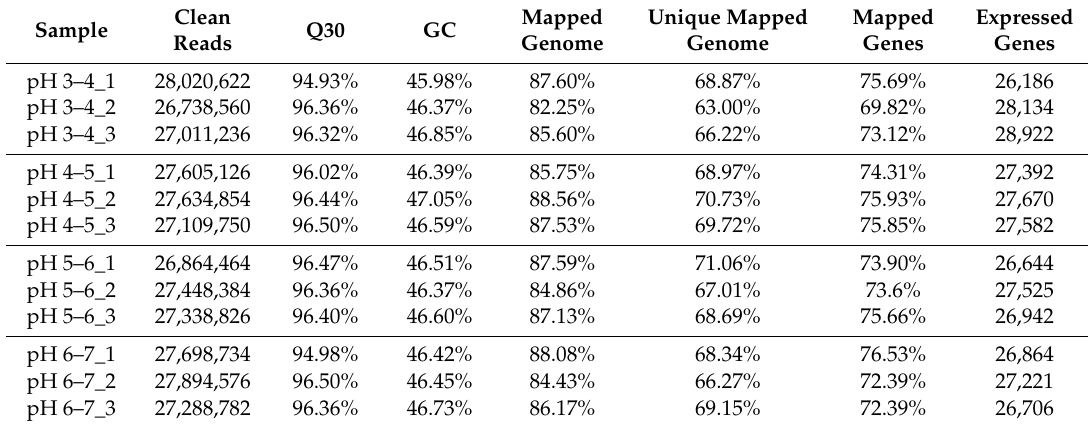
Table 1. Summary of the RNA-seq data obtained from di ff erent